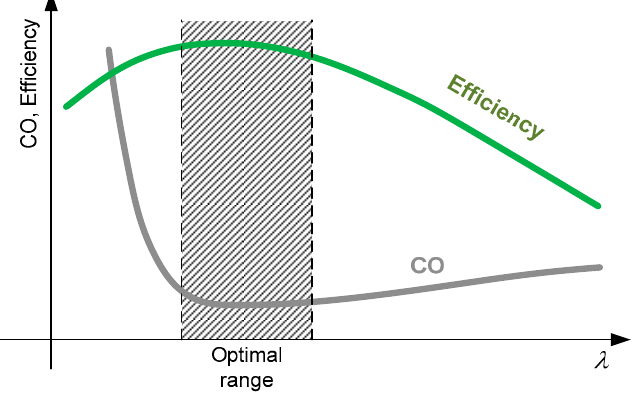
Figure 2. Dependence of the biomass combustion efficiency and CO emissions on the air ratio 𝜆 .